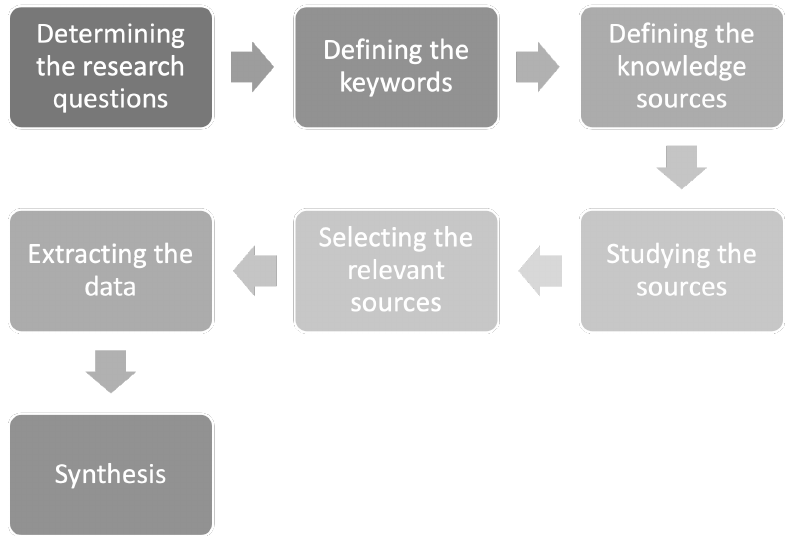
Figure 2. The pipeline of the study